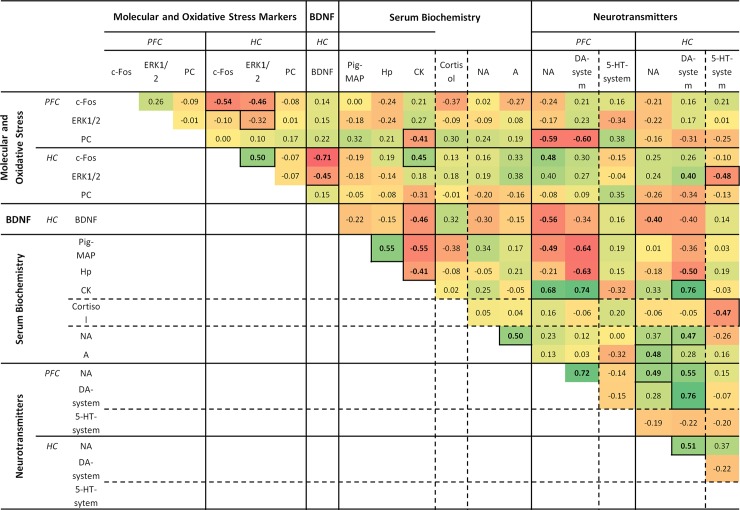
Correlation coefficients of all measured parameters.Bold numbers indicates significant correlations (P < 0.05). Positive correlations are in green and negative correlations are in red. Colour degradation represents the strength of the correlations from R = 1 to R = -1.